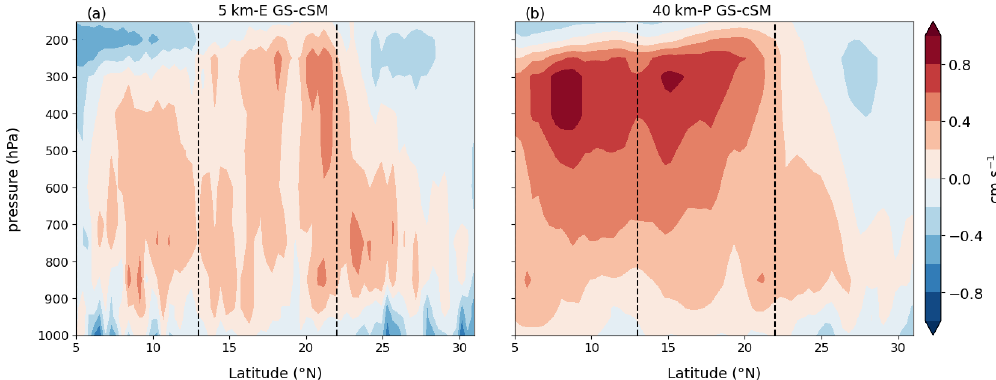
Figure 13. JAS mean meridional cross section of vertical wind speed for the 5km-E GS-cSM (a) and the 40km-P GS-cSM (b) simulation. The vertical dashed lines indicate the boarders of the coastal, Sahel, and Sahara region outlined in Fig.